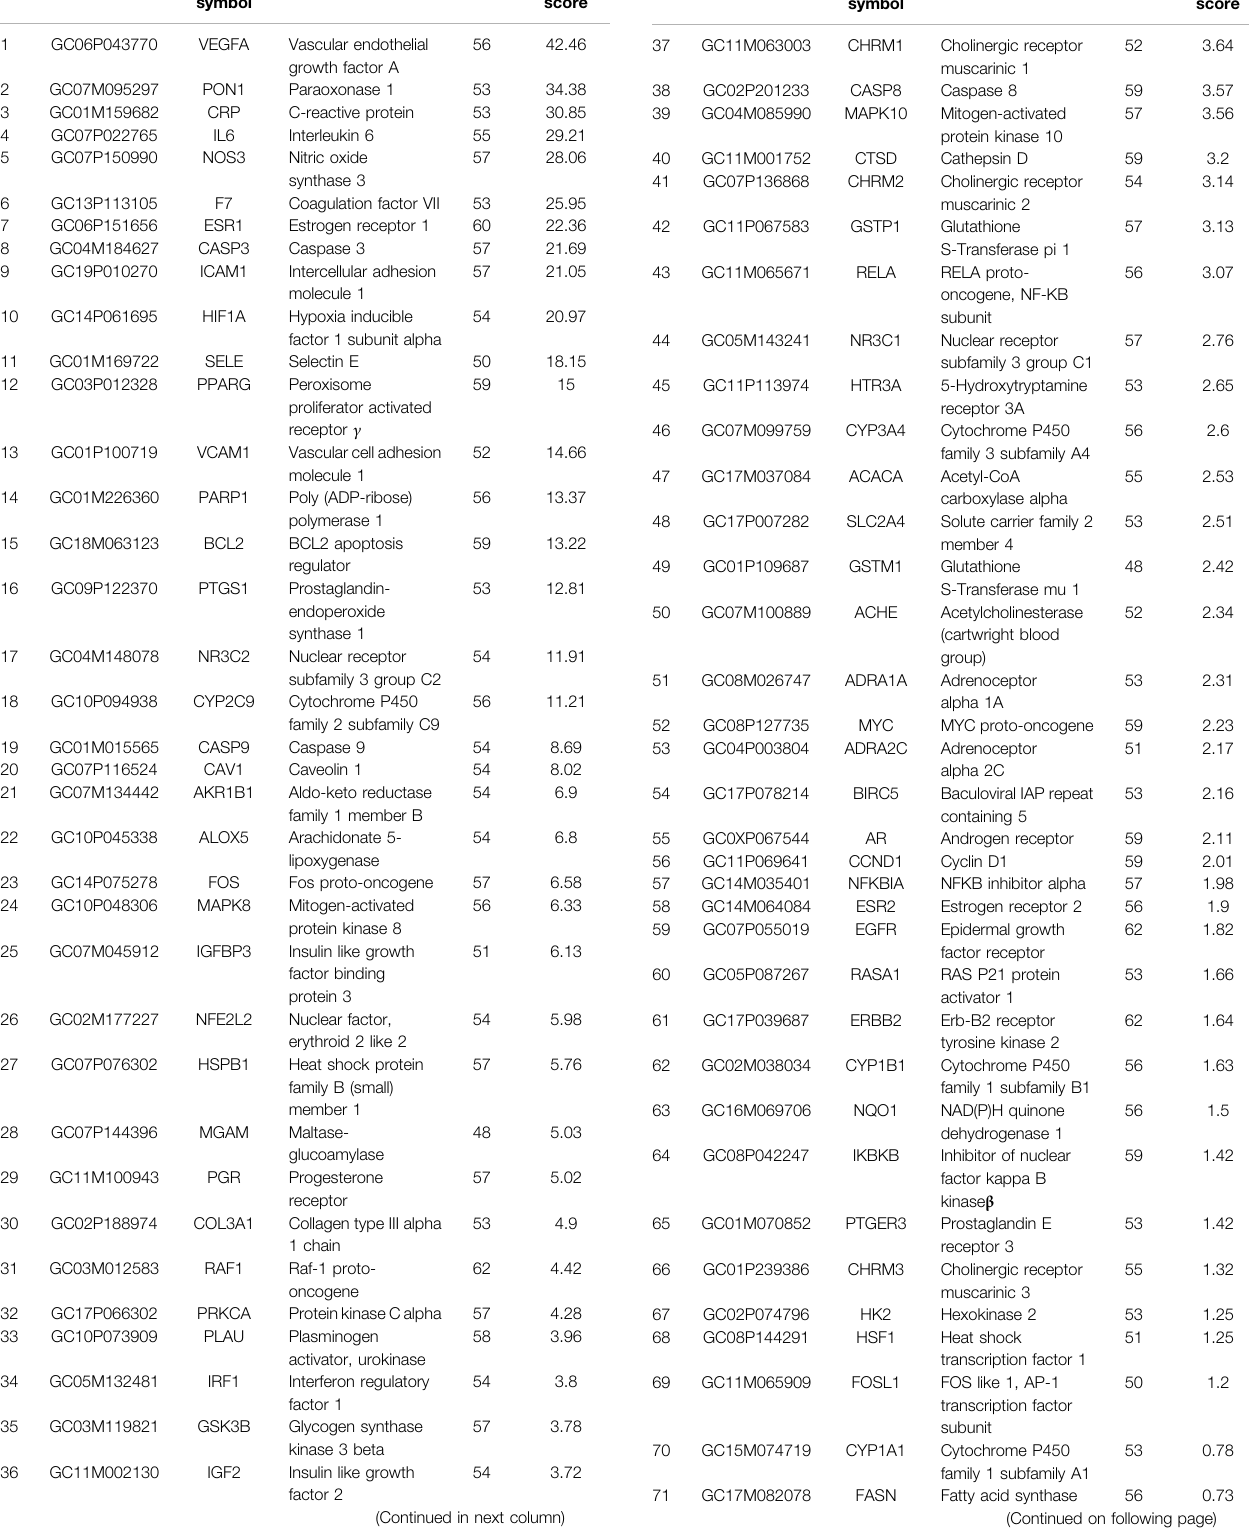
TABLE 2 | Myocardial ischemia (MI) related genes targeted by active compounds of HLJDT.